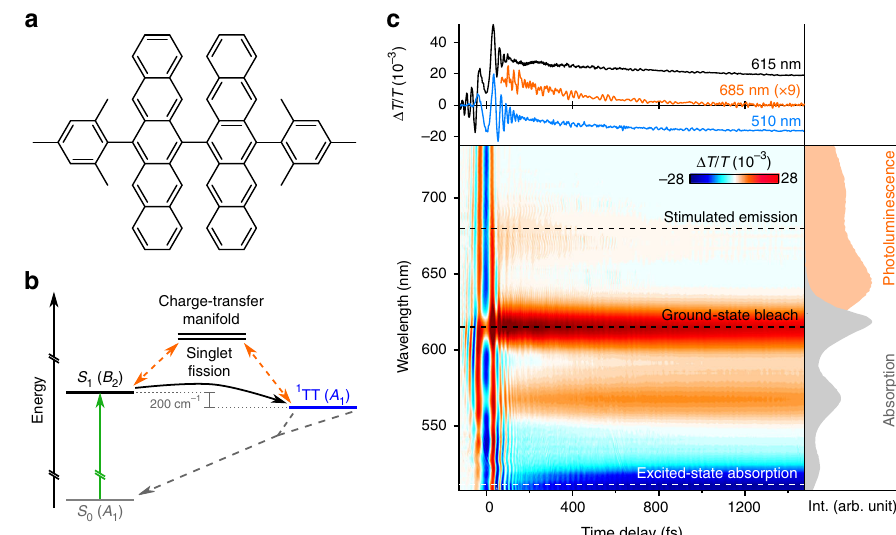
Fig. 1 Structural and optical properties of DP-Mes. a Chemical structure of DP-Mes. Orthogonal ground-state geometry shown in Supplementary Fig. 1. b DP-Mes electronic states and photophysics. Singlet fi ssion from S 1 to 1 TT is mediated by coupling (orange arrows) to a manifold of charge-transfer states which are not directly populated, facilitating the overall marginally exothermic (~200 cm − 1 ) process 46, 47 . Symmetries of the relevant excited electronic states are indicated in parentheses 48 . c Differential transmission map of a DP-Mes thin fi lm following excitation with a 13 fs pulse centred at 550 nm, at room temperature. The absorption (grey) and photoluminescence (orange) spectra are shown to guide spectral assignment. The primary spectral features of S 1 (stimulated emission), 1 TT (excited-state absorption) and total excited-state population (ground-state bleach) are indicated by dashed lines. The associated transient kinetics are shown above, with the weak stimulated emission trace scaled by a factor of 9 for clarity. The superimposed oscillatory modulations correspond to vibrationally coherent wavepackets formed by impulsive excitation. The transient absorption spectrum over an extended probe wavelength range is presented in Supplementary Fig.